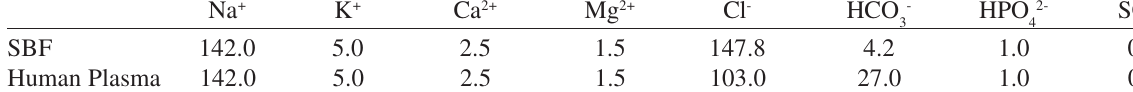
Table 1. Ionic concentration (mM) of human plasma and of Simulated Body Fluid (SBF).